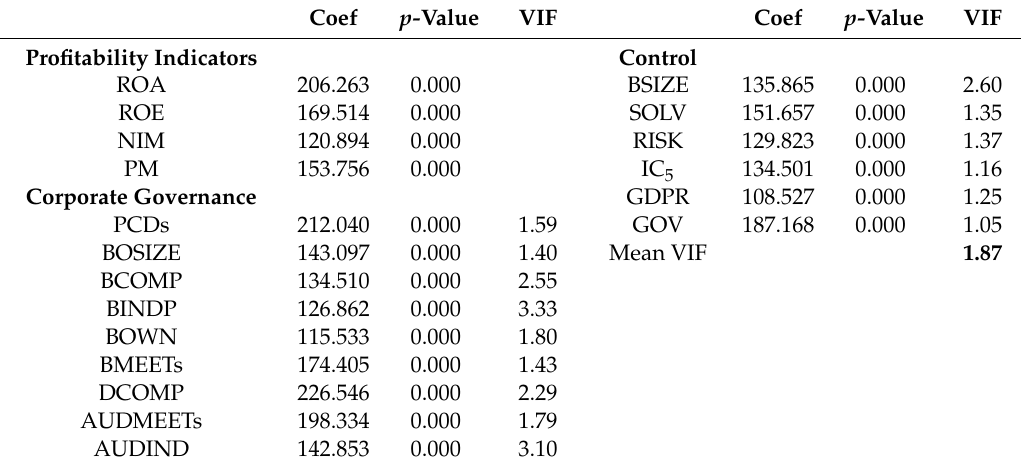
Table 2. Unit root and multicollinearity